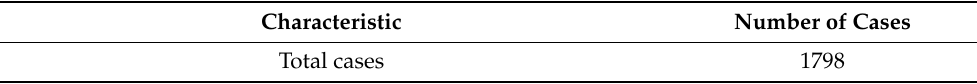
Table 1. Characteristics of human Streptococcus suis cases in Thailand